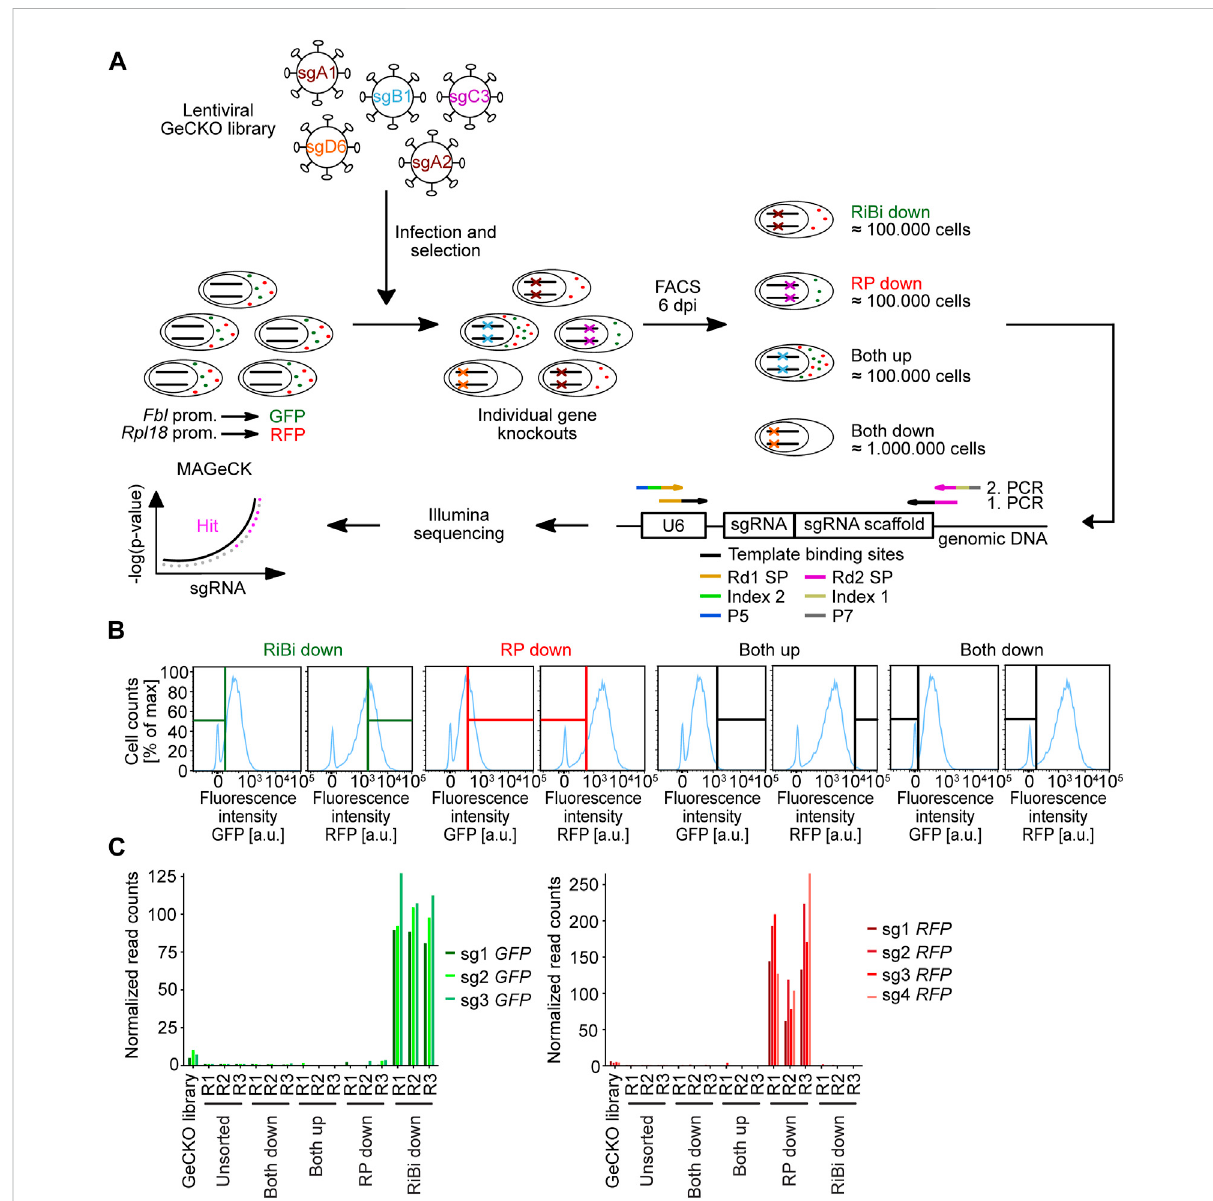
FIGURE 2 Screening procedure and enrichment of positive control sgRNAs across the different conditions. (A) Scheme of the genome-wide CRISPR/ Cas9screeninthe3T3 Fbl -GFP; Rpl18 -RFP cellline.3T3 Fbl − GFP; Rpl18 − RFP isamurineNIH/3T3cellline,thatexpressesEGFP-PEST(GFP)underthecontrolofthe approx. 500 bp Fbl promoter fragment and tRFP-PEST (RFP) under the control of the approx. 500 bp Rpl18 promoter fragment. Prom. = promoter, dpi=dayspostinfection,RiBi=ribosomebiogenesis,RP=ribosomalprotein,U6=U6promoter,sgRNA=singleguideRNA,Rd1SPorRd2SP= readsequencingprimer,P5andP7= fl owcellbindingsites,MAGeCK=model-basedanalysisofgenome-wideCRISPR/Cas9knockoutalgorithm. (B) Gate settings used for sorting the screening samples. The cells were sorted for the indicated populations: cells that displayed high red fl uorescence, but low green fl uorescence, were sorted as the “ RiBi down ” fraction. Cells that showed high green fl uorescence, but low red fl uorescence, were sorted as the “ RP down ” fraction. Cells that presented high or low green and red fl uorescence were sorted into the “ Both up ” or “ Both down ” " fractions, respectively. (C) Enrichment of positive control sgRNAs across the different screening conditions. Analysis of normalized read counts of sgRNAs targeting GFP or RFP in the different conditions of the screen as a ratio over normalized read counts of the unsorted